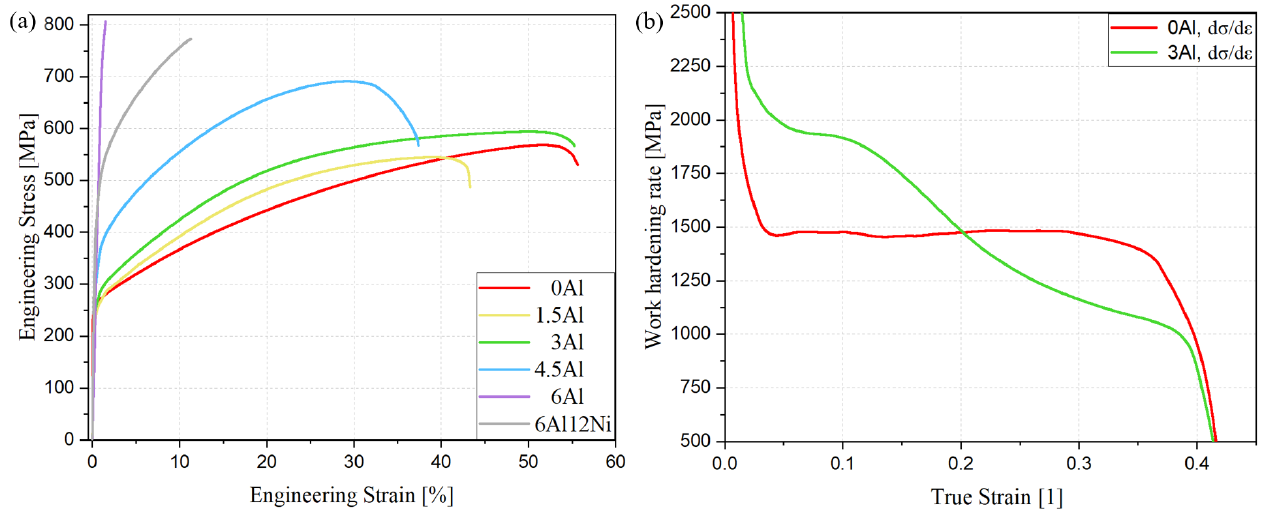
Figure 10. ( a ) Engineering stress – strain curves for all steels; ( b ) true work hardening rates for 0Al and 3Al steels with σ and ε denoting true stress and true strain,